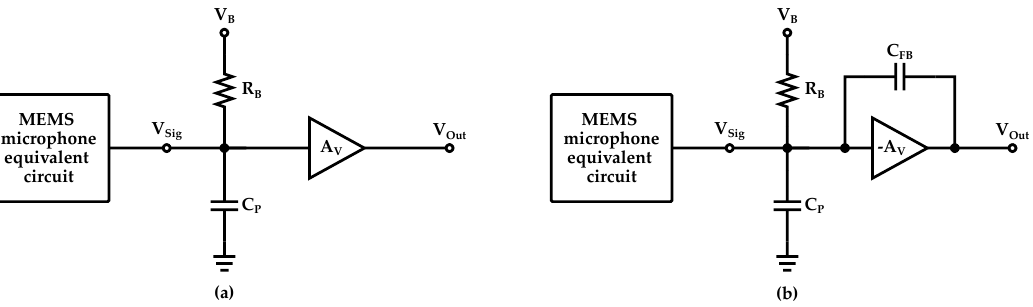
Figure 13. Schematic representation of a ( a ) CC approach and ( b ) CV approach based pre-amp circuit for MEMS microphones.